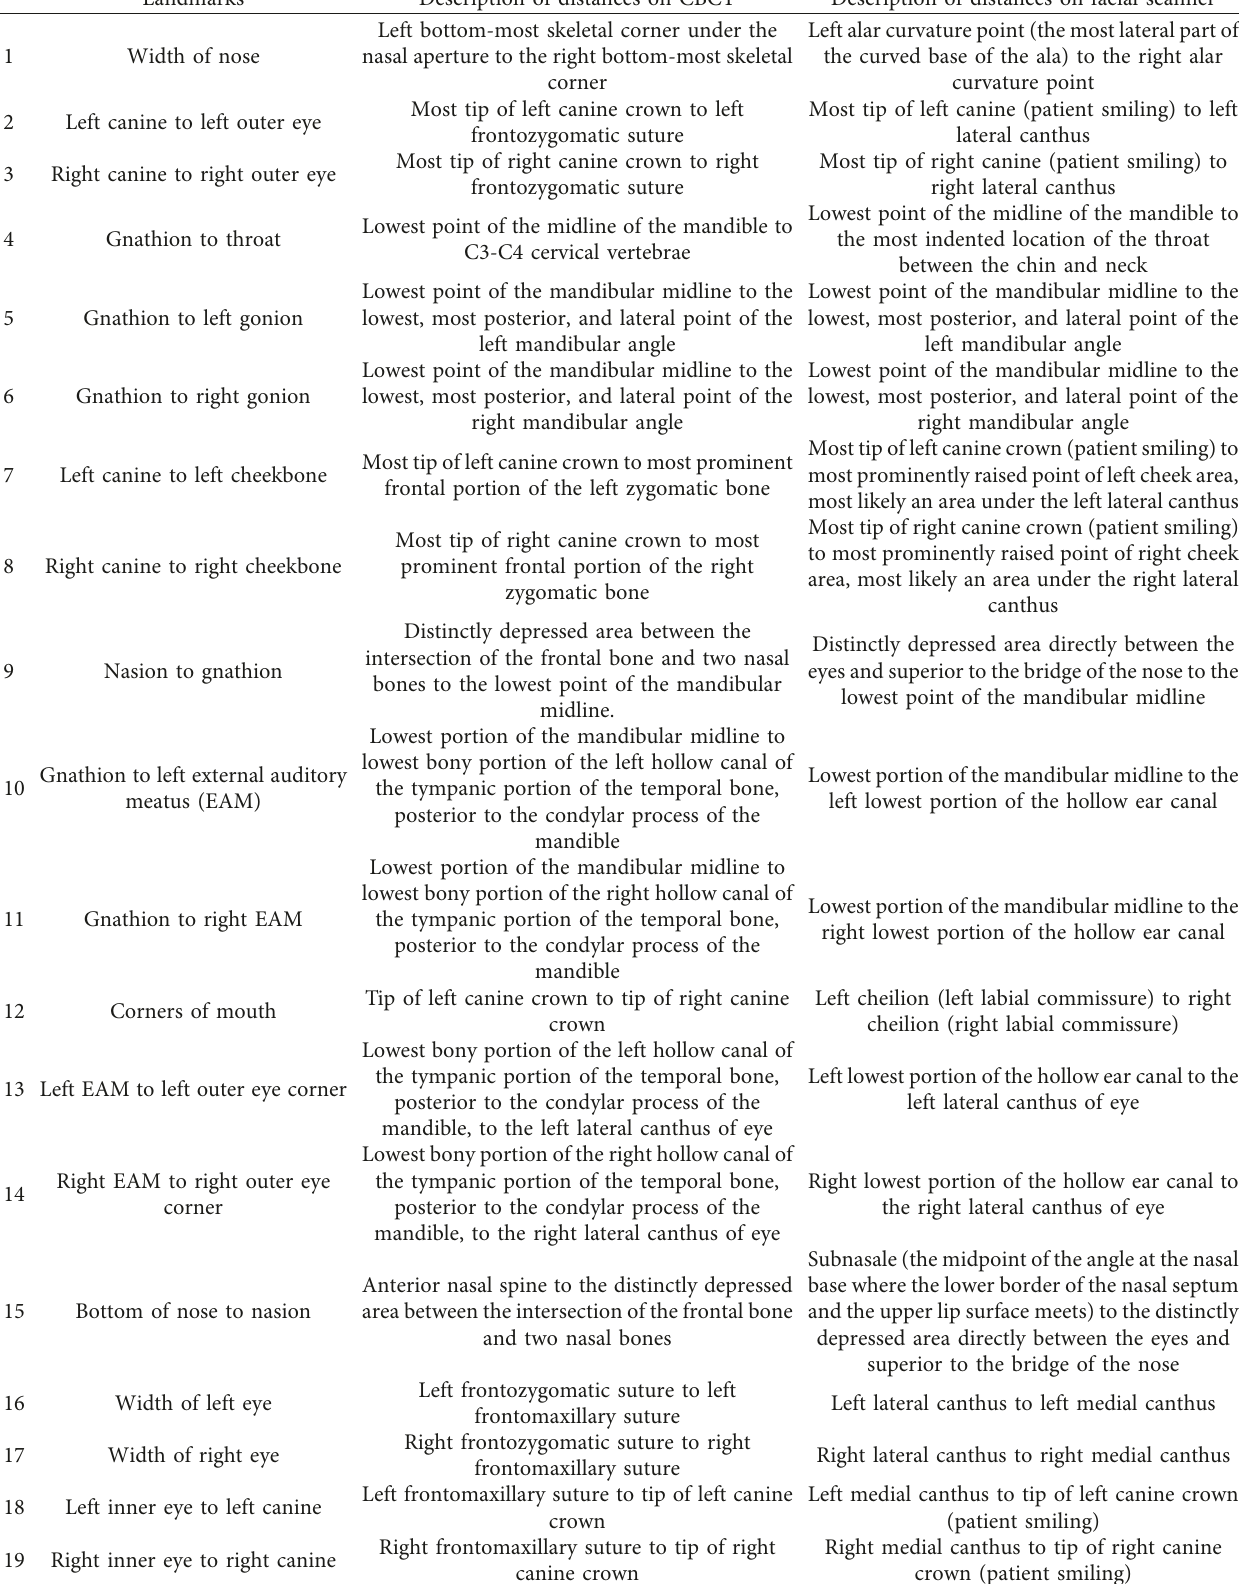
Table 1: Measured and defined distances depending on the image